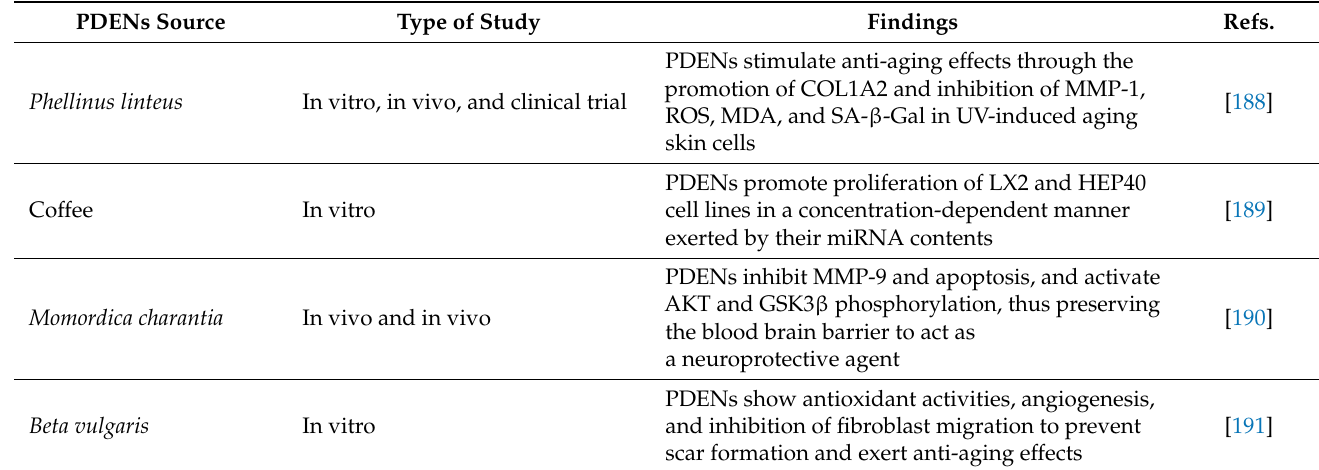
Table 2. Summary of research articles on PDENs in biomedical